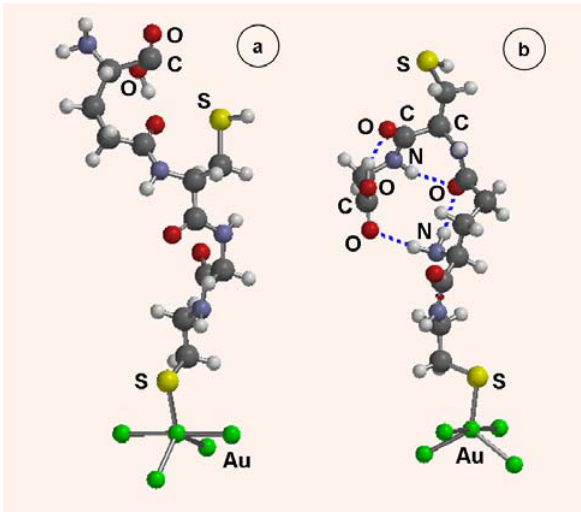
Figure 6. Molecular structure of a CA-GSH molecule chemisorbed on a Au cluster in an open conformation (a) and hydrogen-bonded conformation (b); hydrogen bonds are marked with dashed